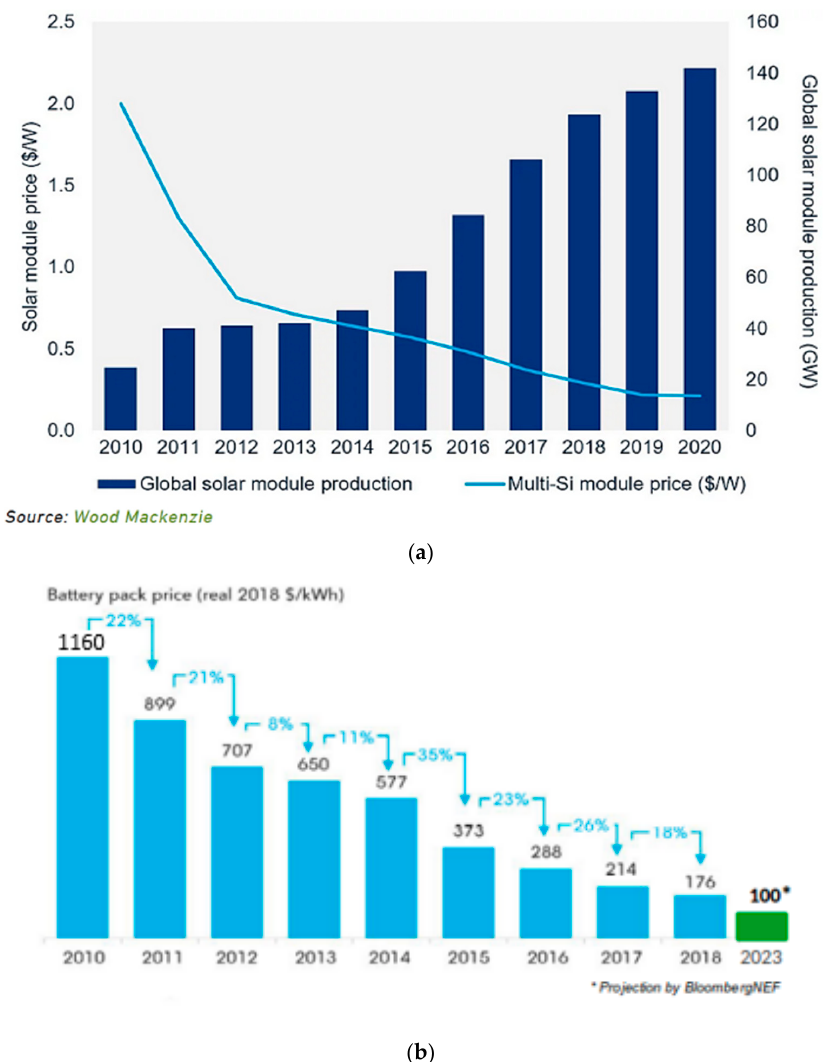
Figure 3. Plummeting prices of ( a ) PV modules [31]; ( b ) lithium-ion battery pack [32].